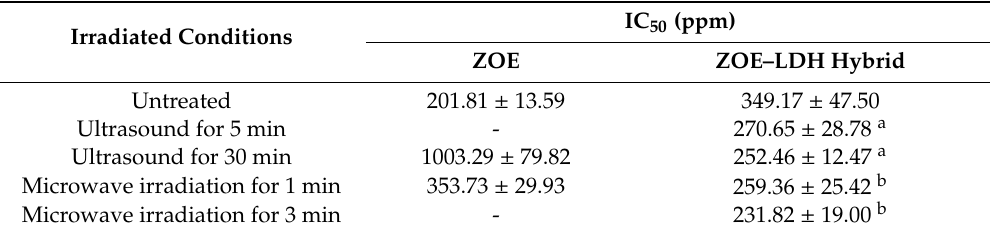
Figure 6. Radical scavenging activity results of ( A ) Zingiber officinale extract (ZOE) in untreated, ultrasound for 30 min and microwave irradiation for 1 min, ZOE–LDH hybrid untreated and irradiation of ( B ) ultrasound and ( C ) microwave. Table 1. IC 50 values of radical scavenging of Zingiber officinale extract (ZOE) and ZOE–LDH (layered double hydroxide) hybrid.